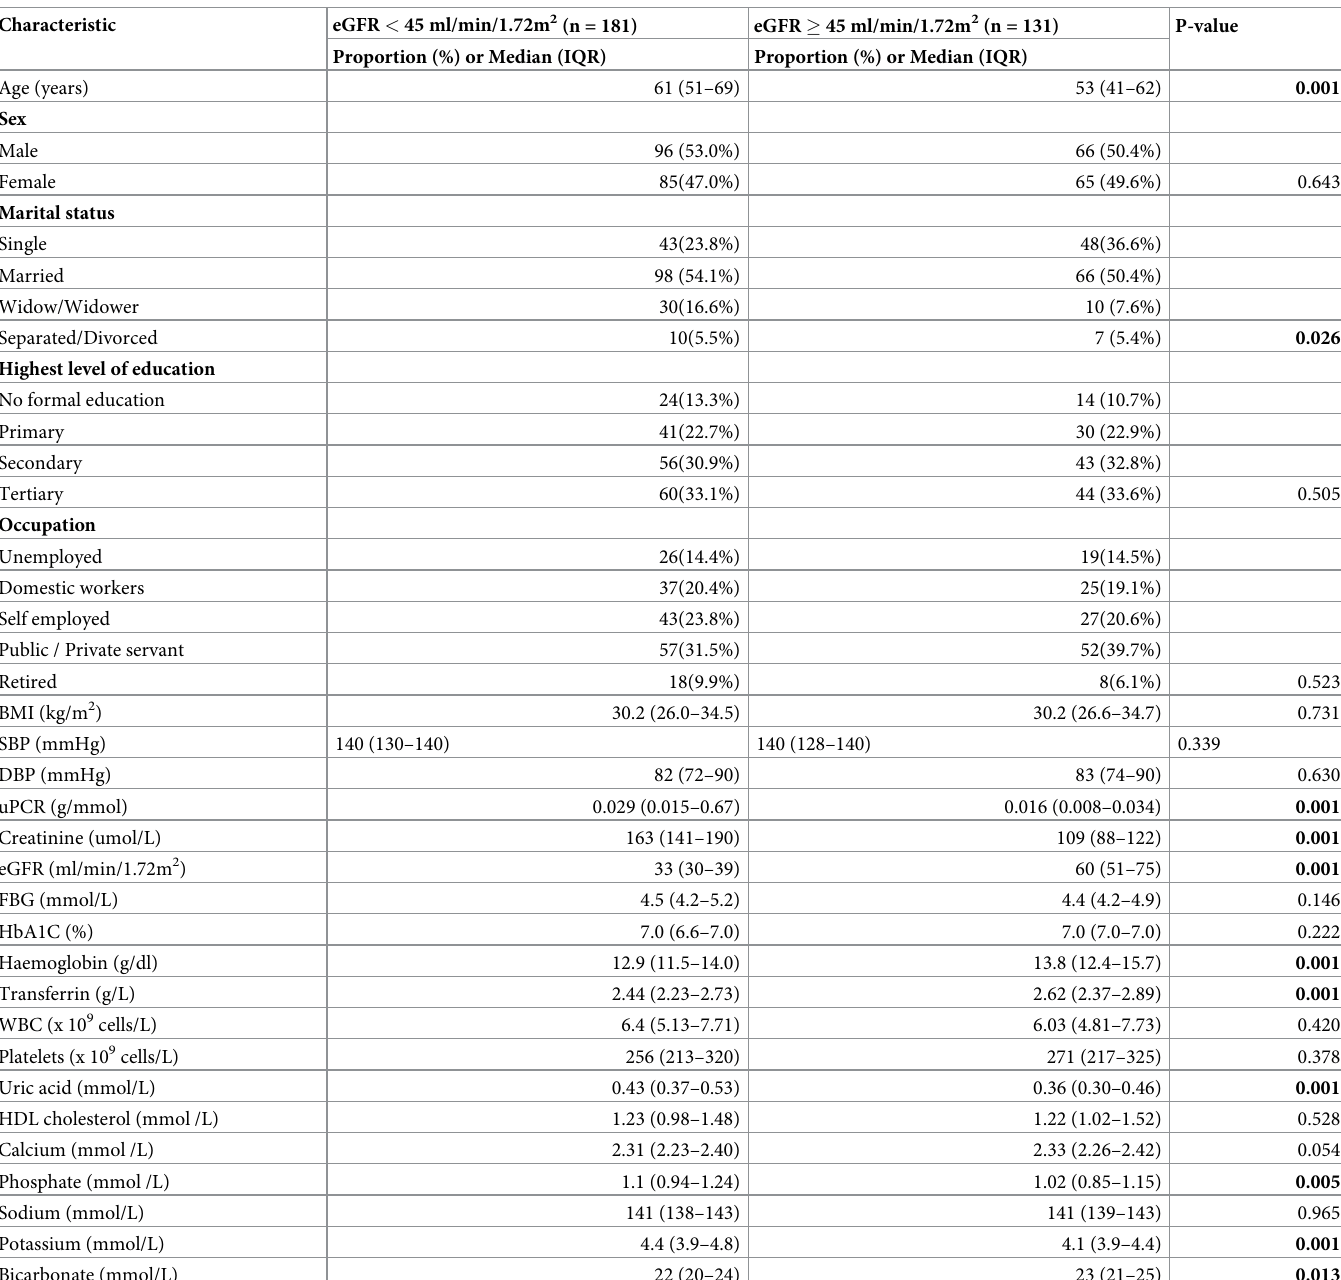
Table 1. Demographic characteristics and clinical profile of 312 CKD patients by eGFR.